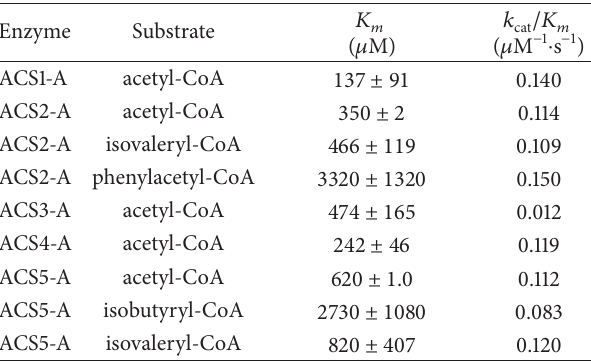
Table 1: Kinetic parameters of ACSx-A isoforms with CoA deriva- tives.